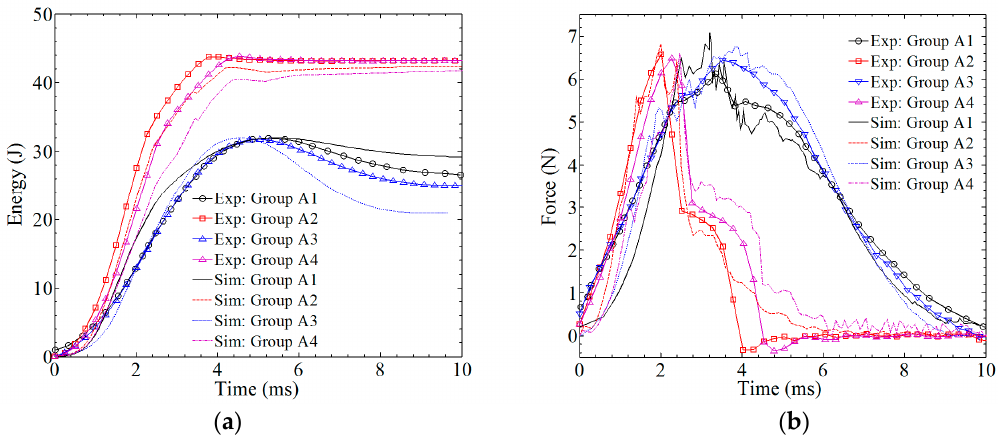
Figure 9. A comparison between the simulation results and the experimental results. ( a ) absorbed energy–time history; ( b ) contact force–time history.